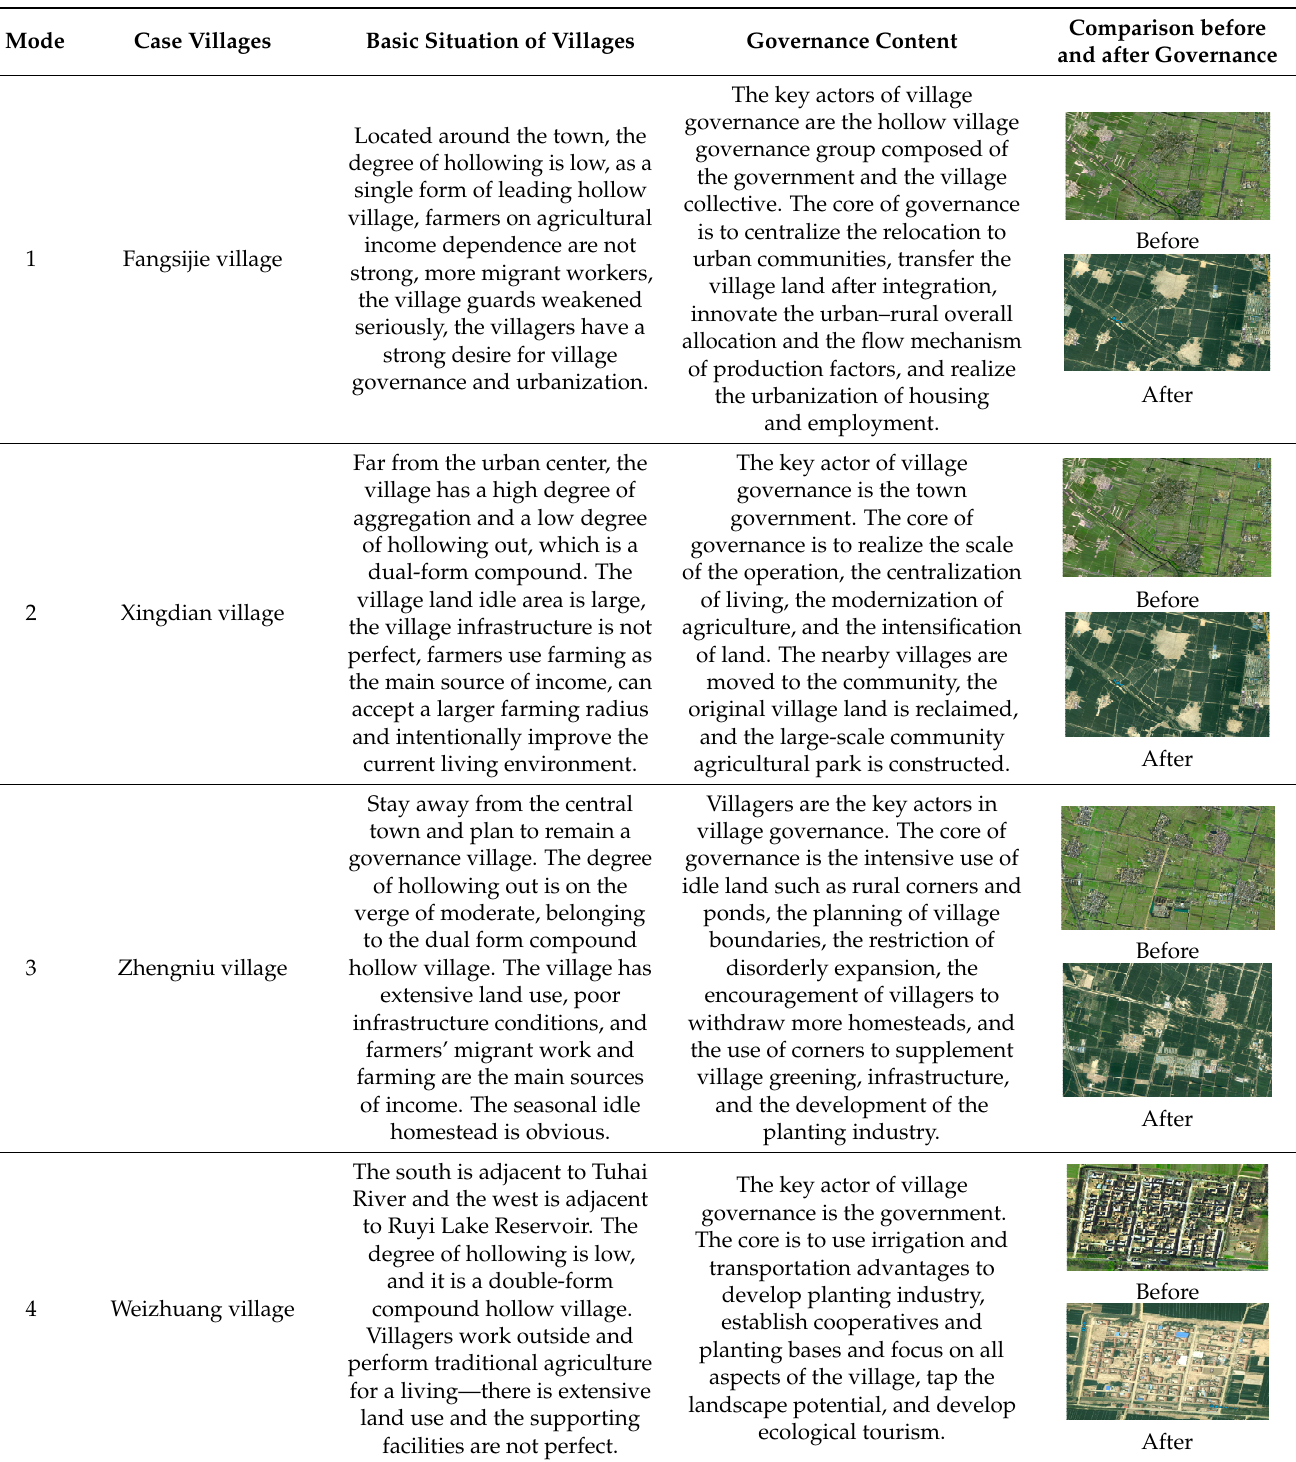
Table 2. Case village governance.